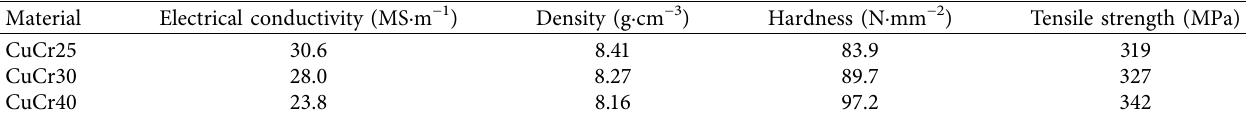
Figure 11: OM images of vacuum cast alloys. (a) CuCr25 alloy; (b) CuCr30 alloy; and (c) CuCr40 alloy [27]. Table 2: Physical and mechanical properties of CuCr alloys [27].